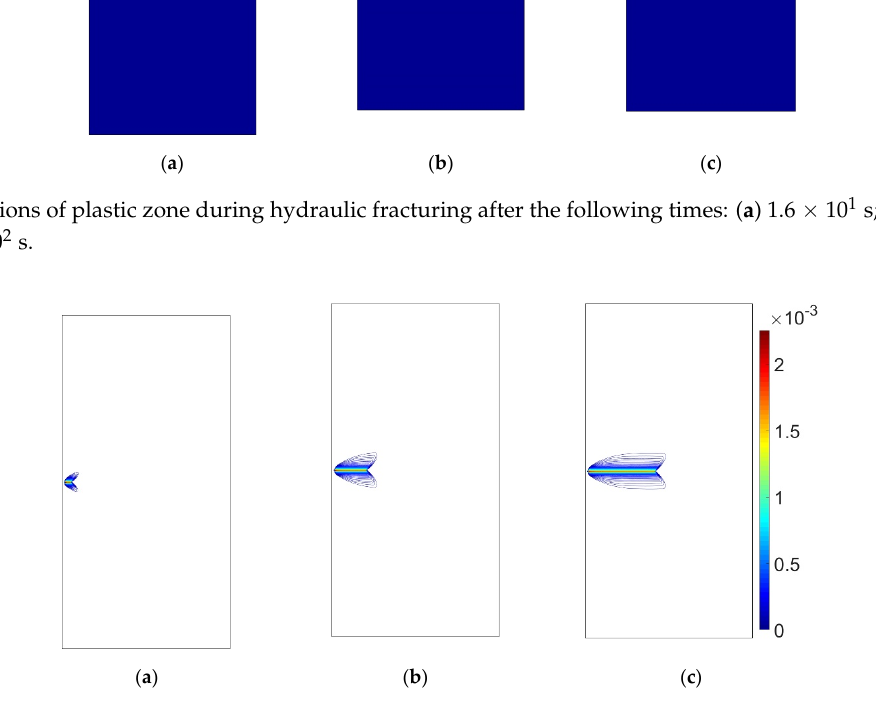
Figure 10. Contours of accumulative equivalent plastic strain after the following times: ( a ) 1.6 × 10 1 s; ( b ) 1.23 × 10 2 s; and ( c ) 3.58 × 10 2 s.